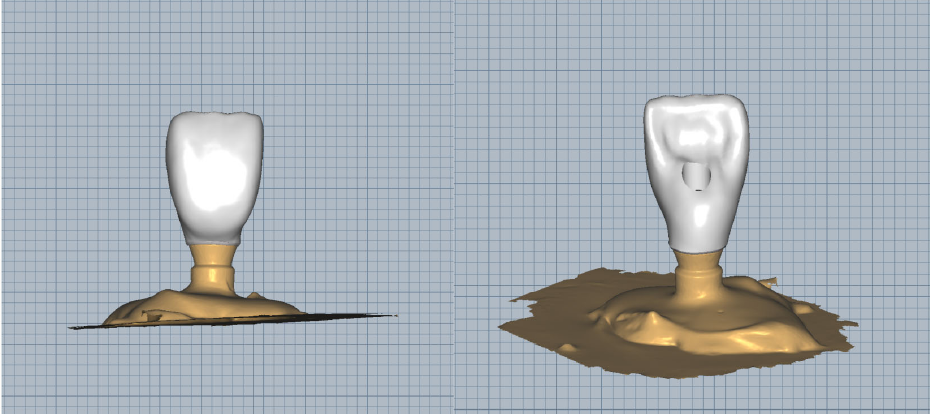
Figure 3. Design of provisional crown. IST: implant stability test.